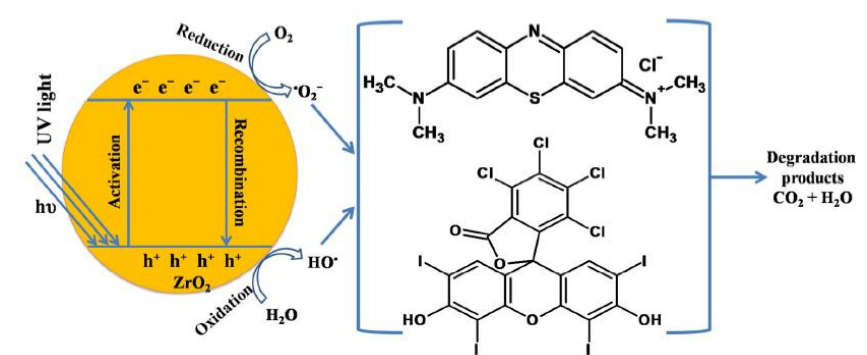
Fig. 10. Photocatalytic degradation mechanism of ZrO2